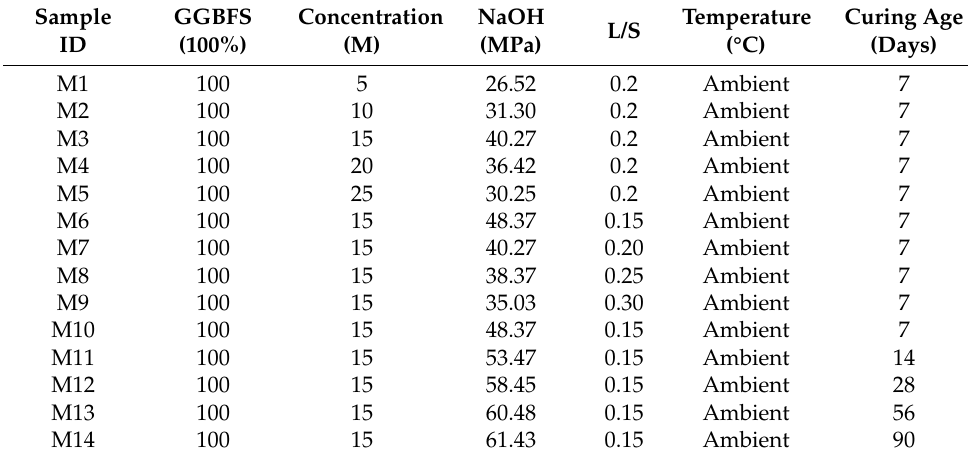
Table 2. Mix design formulations and curing